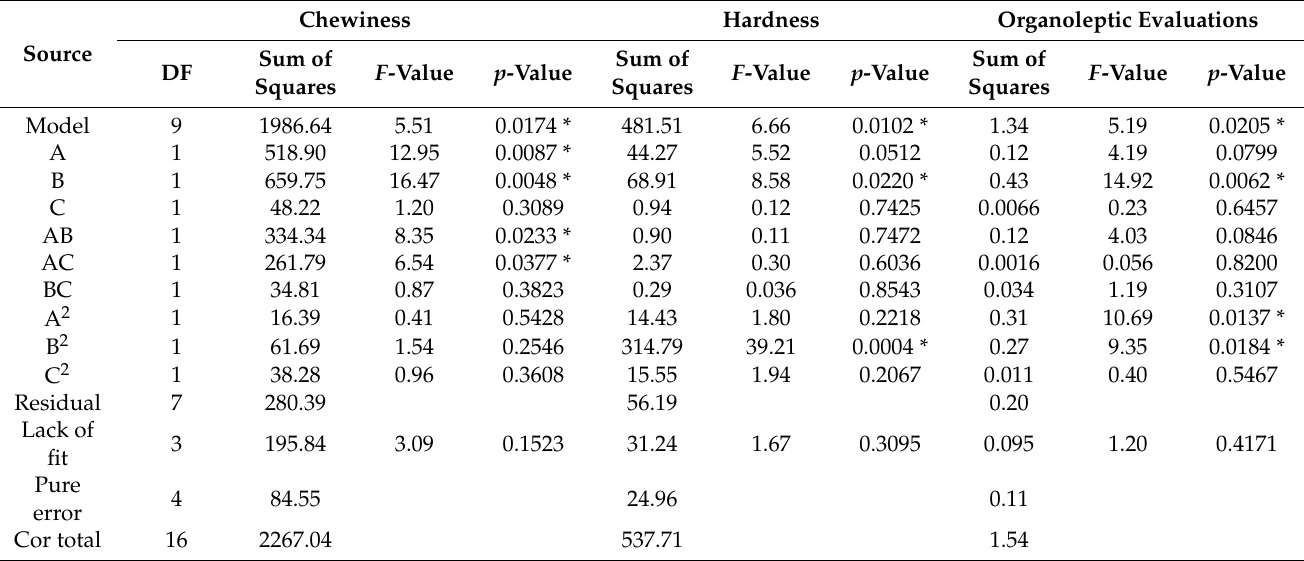
Table 1. Analysis of variance of the regression models for chewiness, hardness, and organoleptic